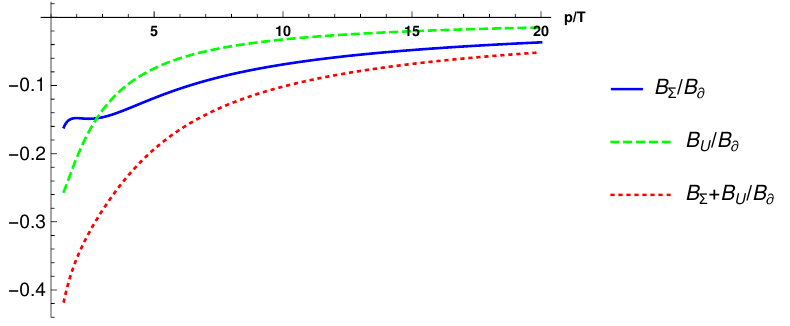
Figure 5 . B M /B ∂ versus p/T for probe fermion mass m = 100 MeV at T = 150 MeV for N f = 2 . B M are defined by A i = B M (cid:15) iml p n p l S mn with M = ∂, Σ , U M